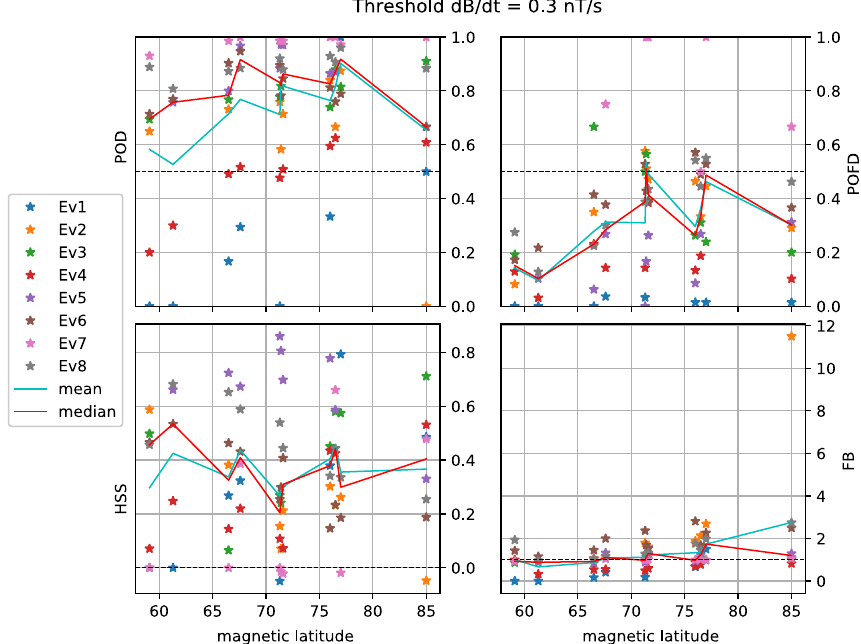
Fig. 7. d B /d t metrics for threshold 0.3 nT/s for all events and magnetometer stations. The cyan and red lines show the mean and median metrics value at each magnetometer station. Metrics shown are probability of detection (POD), Probability of false detection (POFD), Heidke skill score (HSS), and model frequency bias (FB).